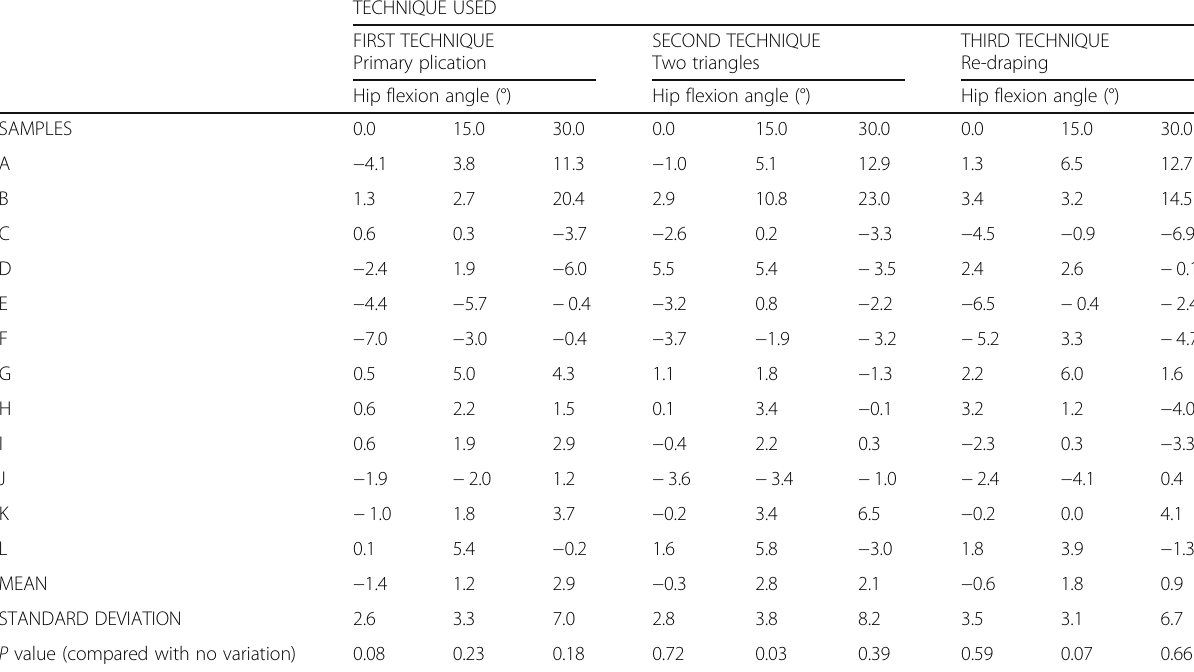
Table 2 Mean variation in angle of external rotation (post plication – pre-plication) TECHNIQUE